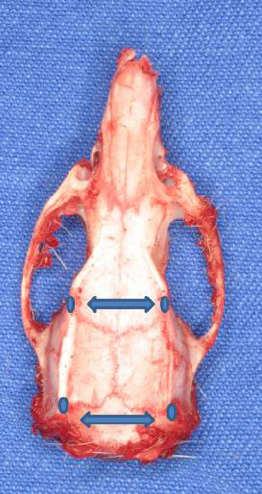
FIGURE 2 - The superior view of dissected craniofacial skeleton of adult age rats that had undergone fetal constraint. Note the landmarks for morphologic measurements of the coronal and lambdoid suture Sagittaly: Landmarks for sagittal morphologic